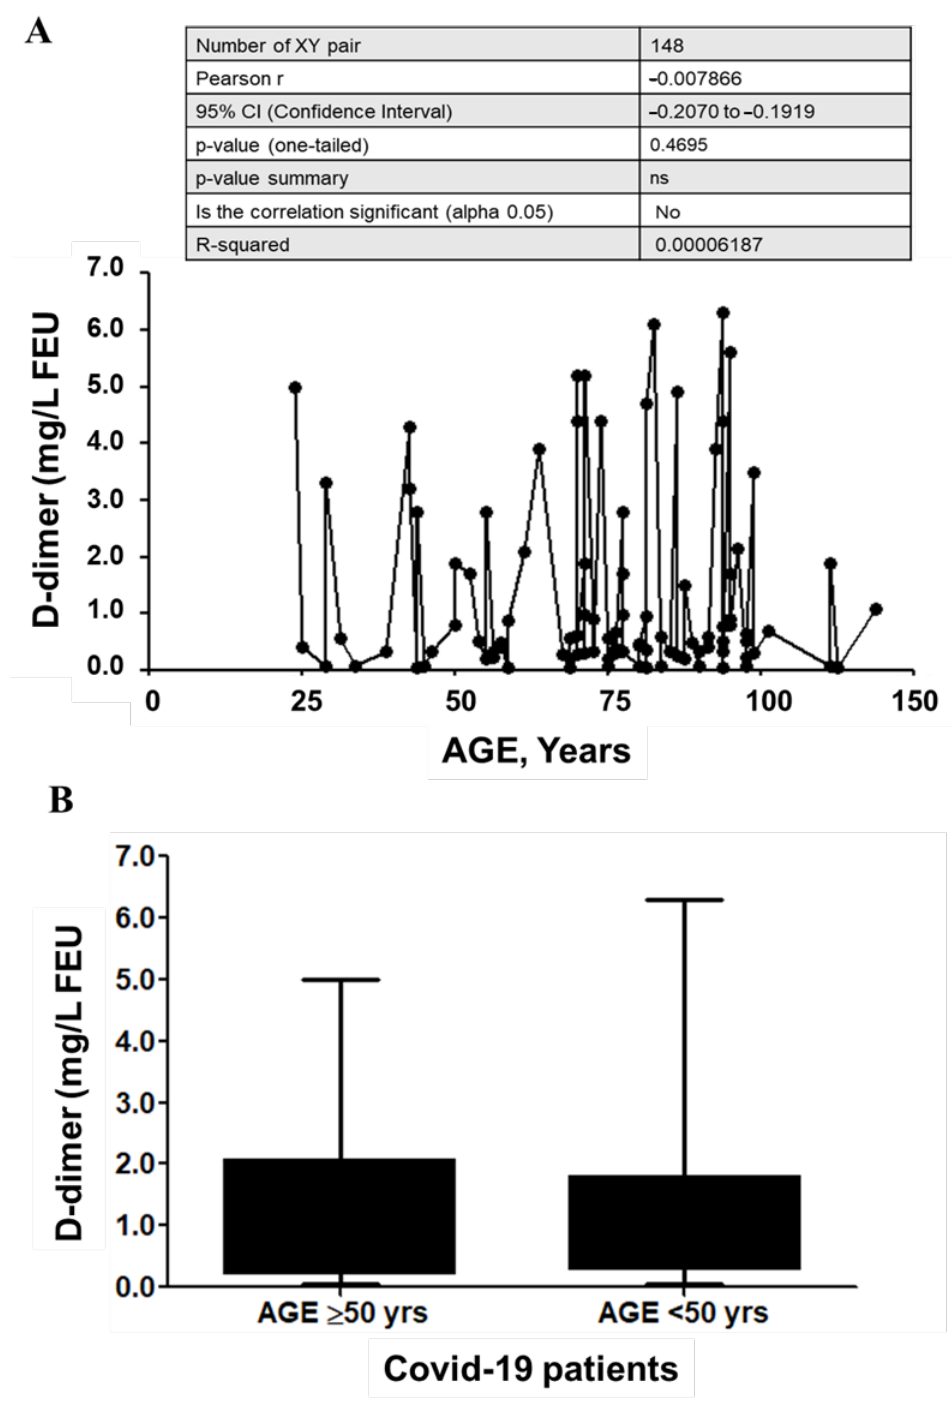
Figure 3. Age-wise distribution of D-dimer levels in COVID-19 patients. ( A ) D-dimer correlation with the age of COVID-19 patients. Pearson r = − 0.007866; p = 0.4695 (95% CI − 0.2070 to 0.1919). ( B ) D-dimer levels in COVID-19 cases with age ≥ 50 years (Age ≥ 50 years; n = 41) and age < 50 years (Age < 50 years; n = 107), p = 0.6869. Box and Whisker show the Min to Max values with median ± SD. Comparison analysis was carried out using a two-way ANOVA method and the Bonferroni post hoc test.